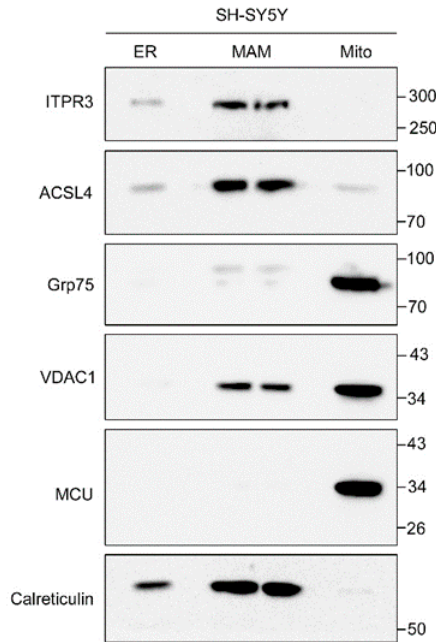
Figure A2. Downregulation of ITPR3 in differentiated STIM1-KO cells. ( a ) Quantification of ITPR1, ITPR2, and ITPR3 transcripts from differentiated STIM1-KO cells compared to wild-type cells. Data are mean ± S.D. from 2 different biological replicates with technical triplicates (n = 6). ( b ) ITPR3 protein expression in whole cell lysates was quantified in differentiated wild-type and STIM1-KO cells (beta- tubulin as a loading control). Data are mean ± S.D. from 2 independent experiments.